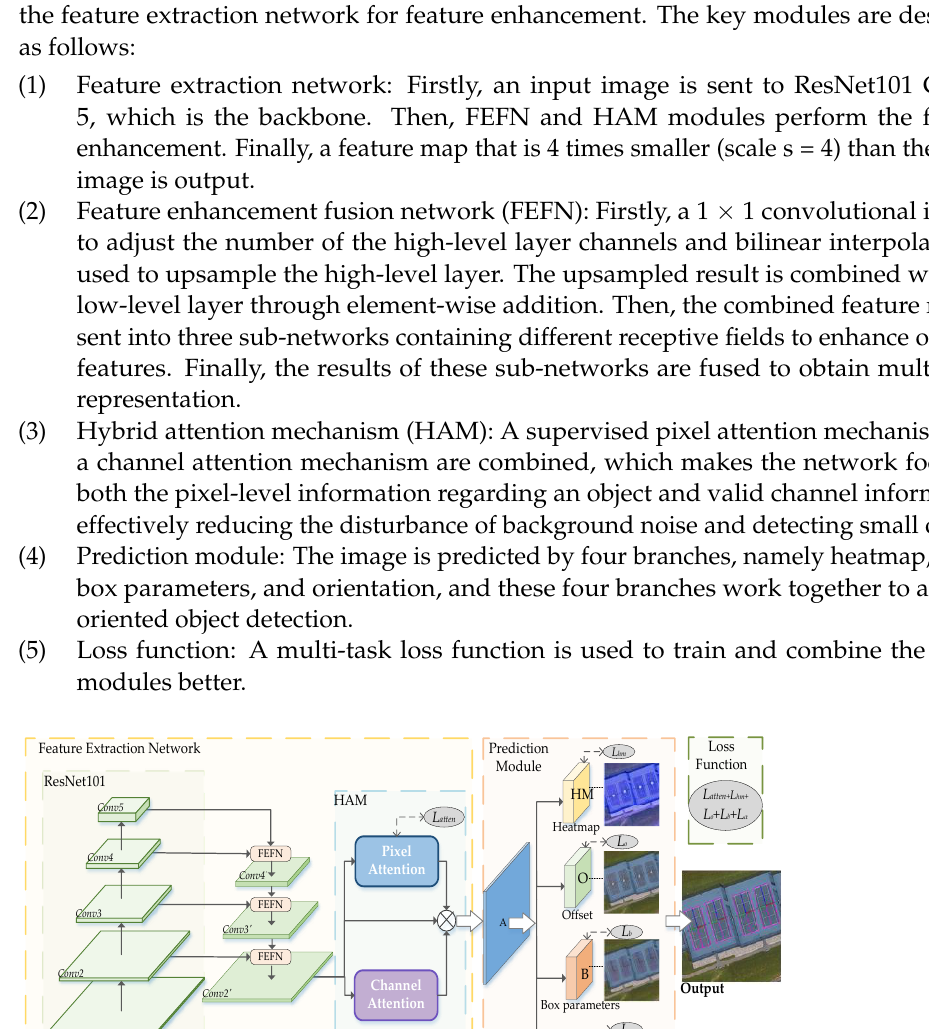
Channel Attention